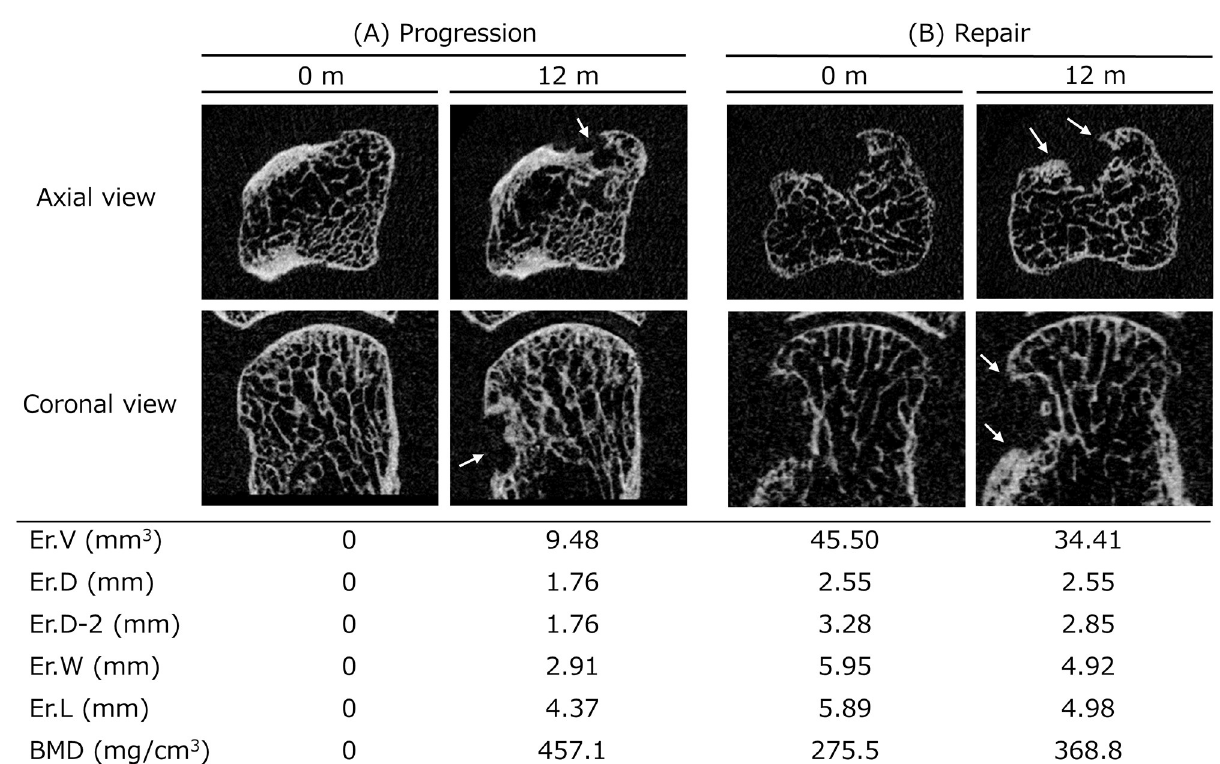
Fig 6. Two representative images of a longitudinal erosion change in patients with RA. Each 2D MCH image represents an image at baseline (0 months) and at follow-up (12 months) from both the axial view (upper) and the coronal view (lower). A. New erosion is evident in a 74-year-old patient (white arrows indicate new erosion). Clinical data at baseline were as follows: treatment with tocilizumab; disease duration, 60 months; rheumatoid factor (RF), positive; C-reactive protein (CRP), 0.89 mg/L; Disease Activity Score in 28 joints (DAS28)-CRP, 6.70. B. Partial repair of erosion is evident in a 49-year-old patient (white arrows indicate new bone formation). Clinical data at baseline were as follows: treatment with adalimumab; disease duration, 24 months; RF, negative; CRP, 1.42 mg/L; DAS28-CRP, 3.95.